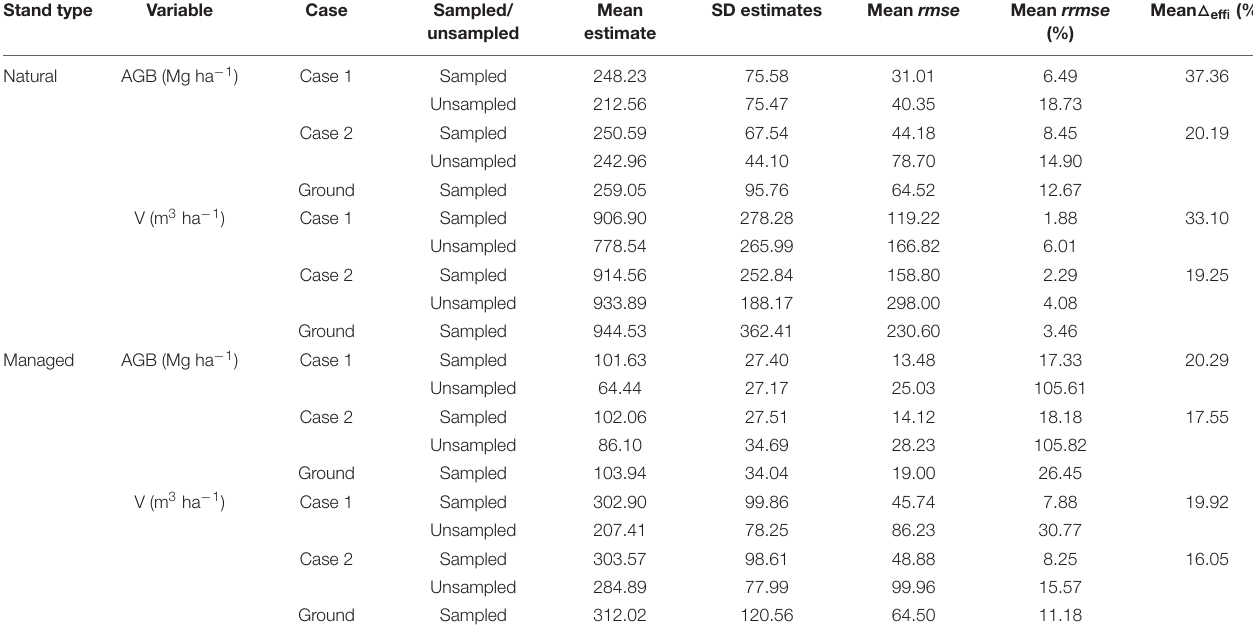
TABLE 4 | Summary of stand-level estimates, uncertainties, and improvements in efficiency for FH models by type of stands (i.e., natural vs. managed stands), response variable (i.e., above-ground biomass, AGB, and volume, V), and case scenario (i.e., Case 1 and Case 2). Stand type